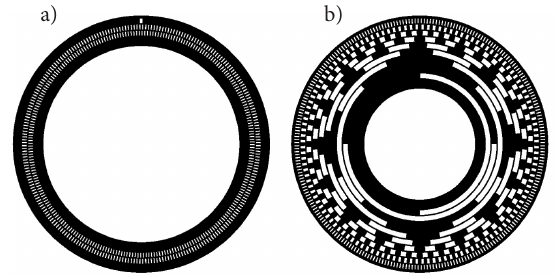
Fig. 1. types of circular scales used in a) incremental encoders; b) absolute